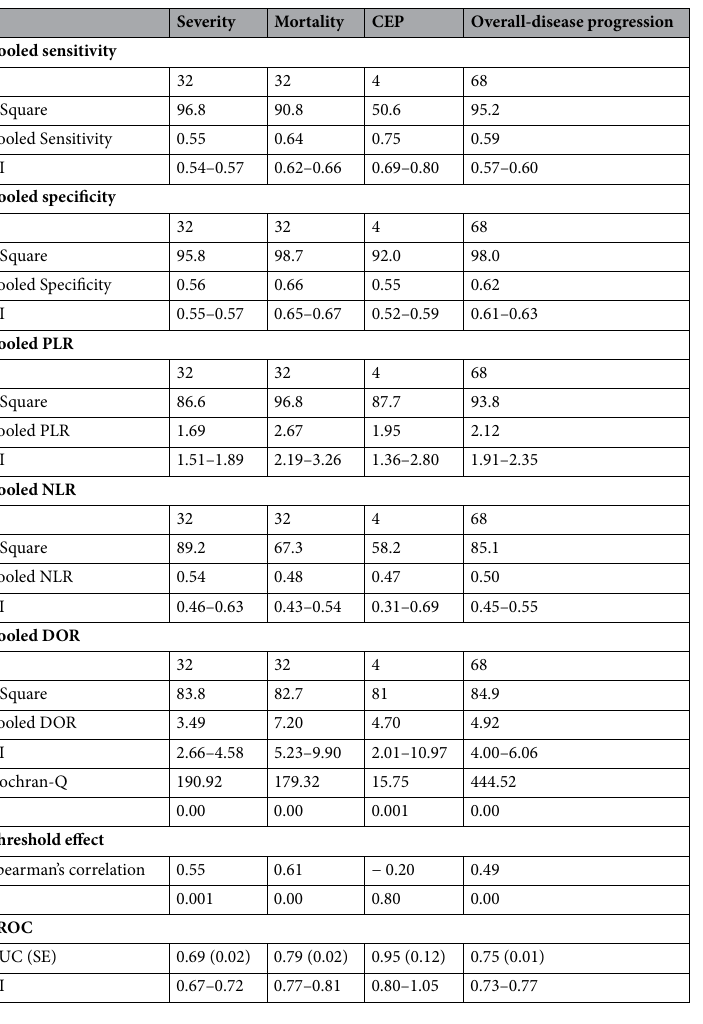
Table 1. Pooled estimates of sensitivity, specificity, diagnostic odds ratio, and AUC values of D-dimer for predicting disease progression. AUC = area under curve. CEP = composite end points. CI = confidence interval. DOR = diagnostic odds ratio. NLR = negative likelihood ratio. PLR = positive likelihood ratio. SROC = summary receiver operating